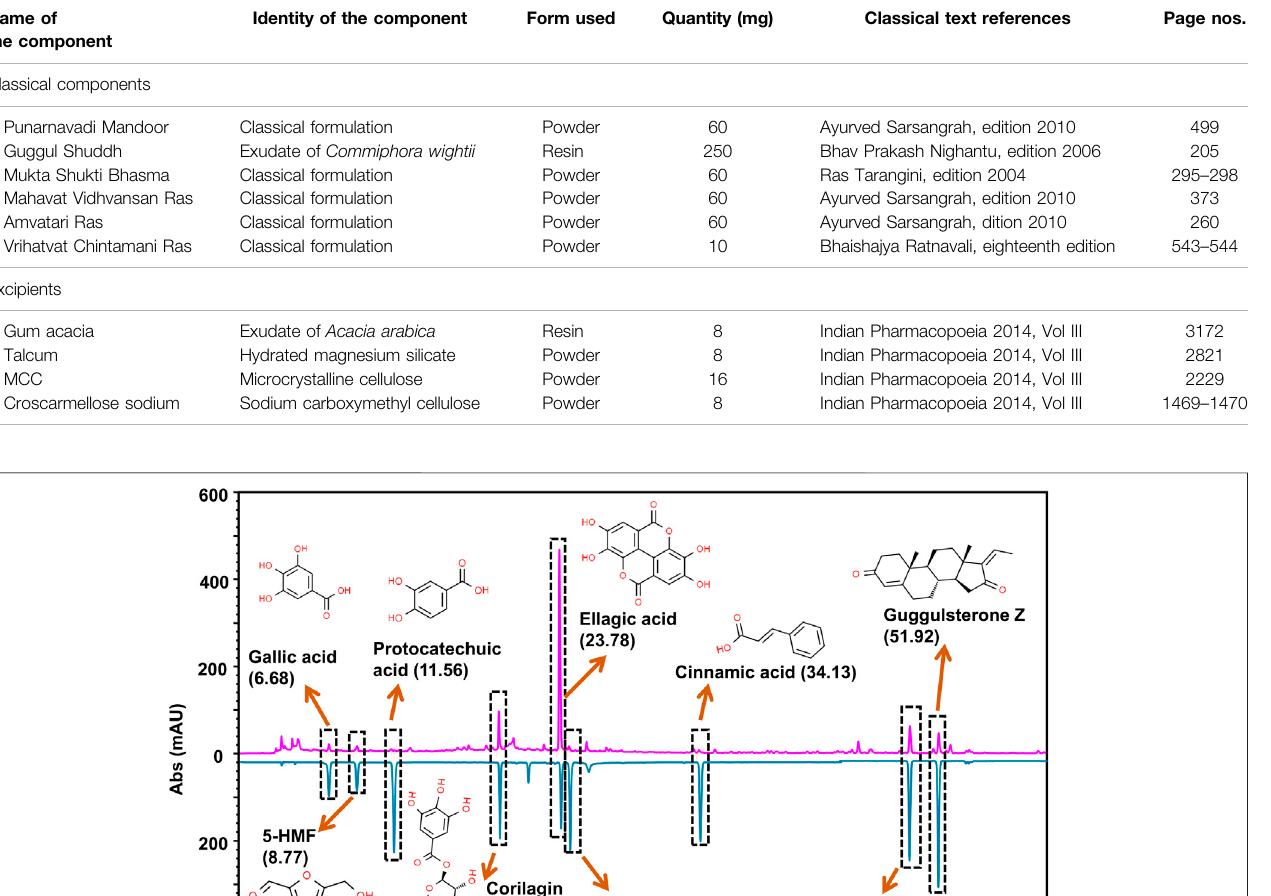
TABLE 1 | Composition of Peedanil Gold (PN-G).